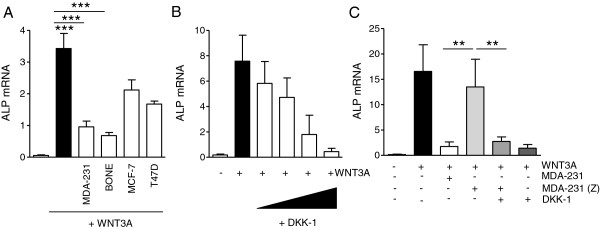
Dickkopf-1 inhibits WNT3A-induced osteoblastic differentiation in C2C12 cells. (A) Supernatants of breast cancer cells were harvested after 48 hours. C2C12 cells were cultured in control medium (containing 50% control L-cell medium) or differentiated in WNT3A-containing media (50%) and concurrently treated with breast cancer supernatants (25%) or unconditioned control media (25%). C2C12 cells were treated for 48 hours and assessed for alkaline phosphatase (ALP) expression. (B) C2C12 cells were differentiated with WNT3A media and exposed to increasing concentrations of recombinant Dickkopf-1 (DKK-1; 10, 50, 100 and 250 ng/ml). (C) C2C12 cells were exposed to supernatants of untreated or zoledronic acid-treated MDA-231 cells in the presence of WNT3A. To prevent potential direct effects of zoledronic acid on C2C12 cells, MDA-231 cells were preincubated with zoledronic acid for 24 hours, media were then replaced and zoledronic acid-free supernatants were harvested 48 hours later. Results of polymerase chain reaction data are presented as the mean ± standard deviation of three independent experiments. *P < 0.01; ***P < 0.001.